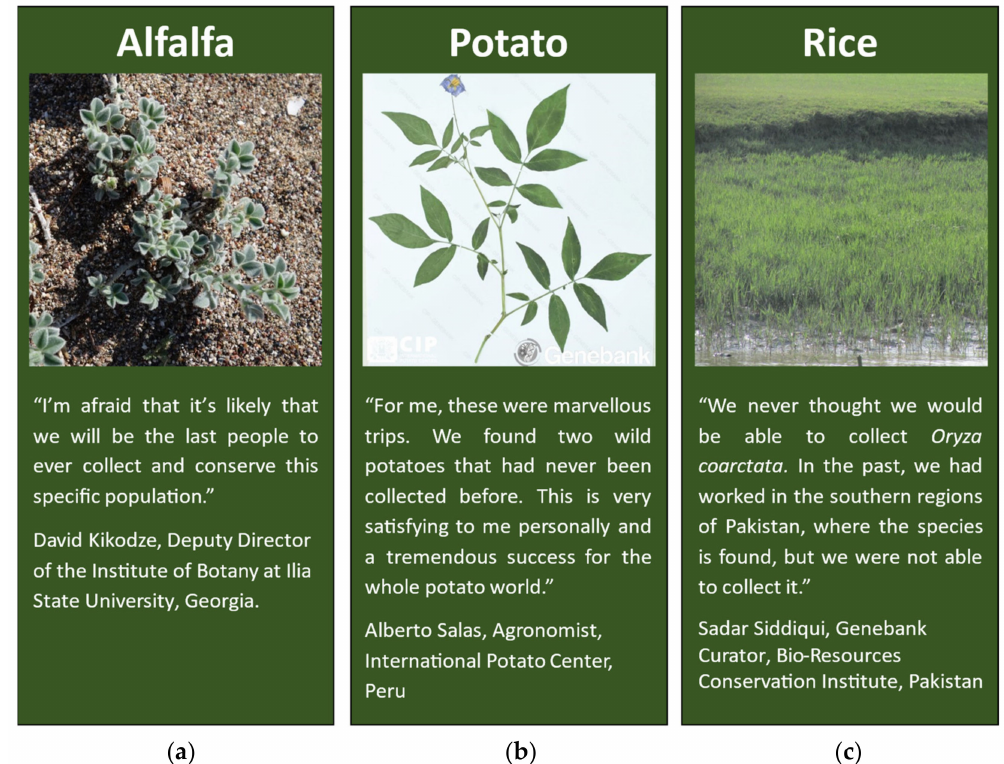
Figure 5. Collectors share their comments on collections of alfalfa, potato and rice. ( a ) Quote refers